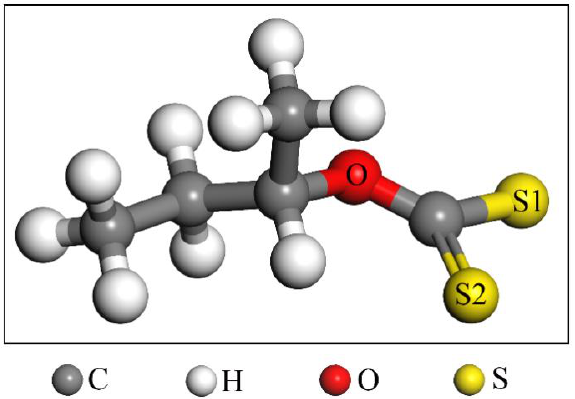
Figure 4. Butyl xanthate (BX) model after geometric optimization. The adsorption energy equation of BX adsorbed onto the surface of sphalerite (110) is shown by Equation